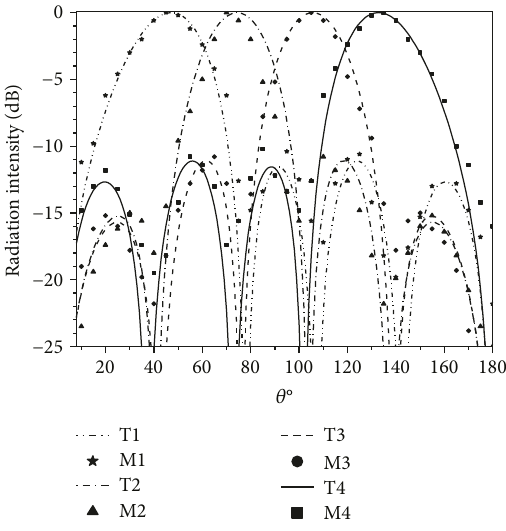
Figure 12: Normalized radiation patterns at 2.44GHz of the 4-element antenna array fed by the 4 × 4 BM shown in Figure 2(b). The curves T1-T4 depict the theoretical results that correspond to beams 1-4, respectively, of Table 1. Accordingly, M1-M4 stand for the measurements.